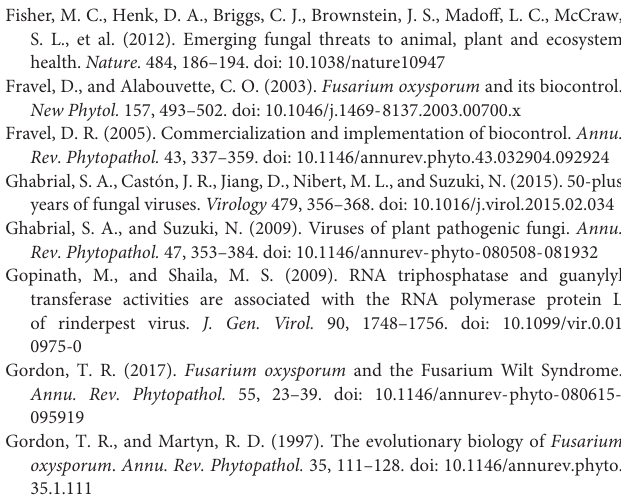
Supplementary Figure 1 | Agarose gel electrophoresis of Partial FoMyV1 genome validated by RT-PCR with seven primers. Supplementary Figure 2 | RT-PCR detection of FoMyV1 in strain LJ3-3, LJ4-1, and derivative strain B9-VI. Supplementary Figure 3 | FoMyV1 detection by DNA template of strain LJ3-3. Supplementary Figure 4 | RT-PCR detection of FoMyV1 in the conidia progeny of strain LJ3-3. Supplementary Figure 5 | RT-PCR detection of FoMyV1 from re-isolated strain in the root of B9-VI infected